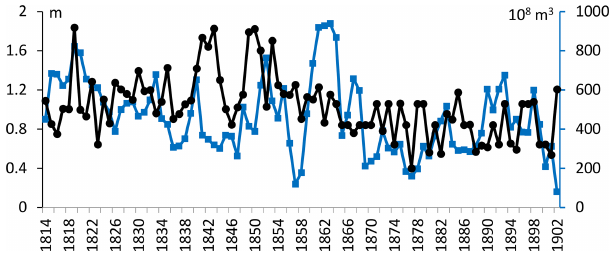
Figure 6. Runoff of the Yellow River at Sanmenxia (thick blue line with squares) over 1814–1902 and its comparison with the annual mean water level of Lake Machang (thin black line with